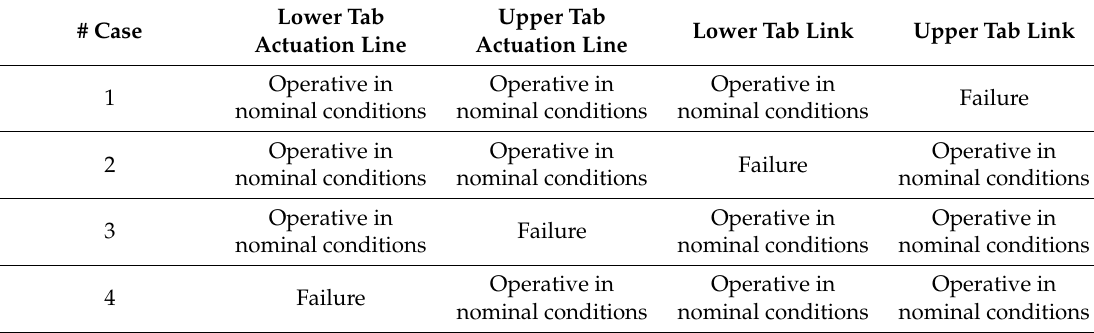
Table 4. Potential failures identified in morphing winglet preliminary FHA.